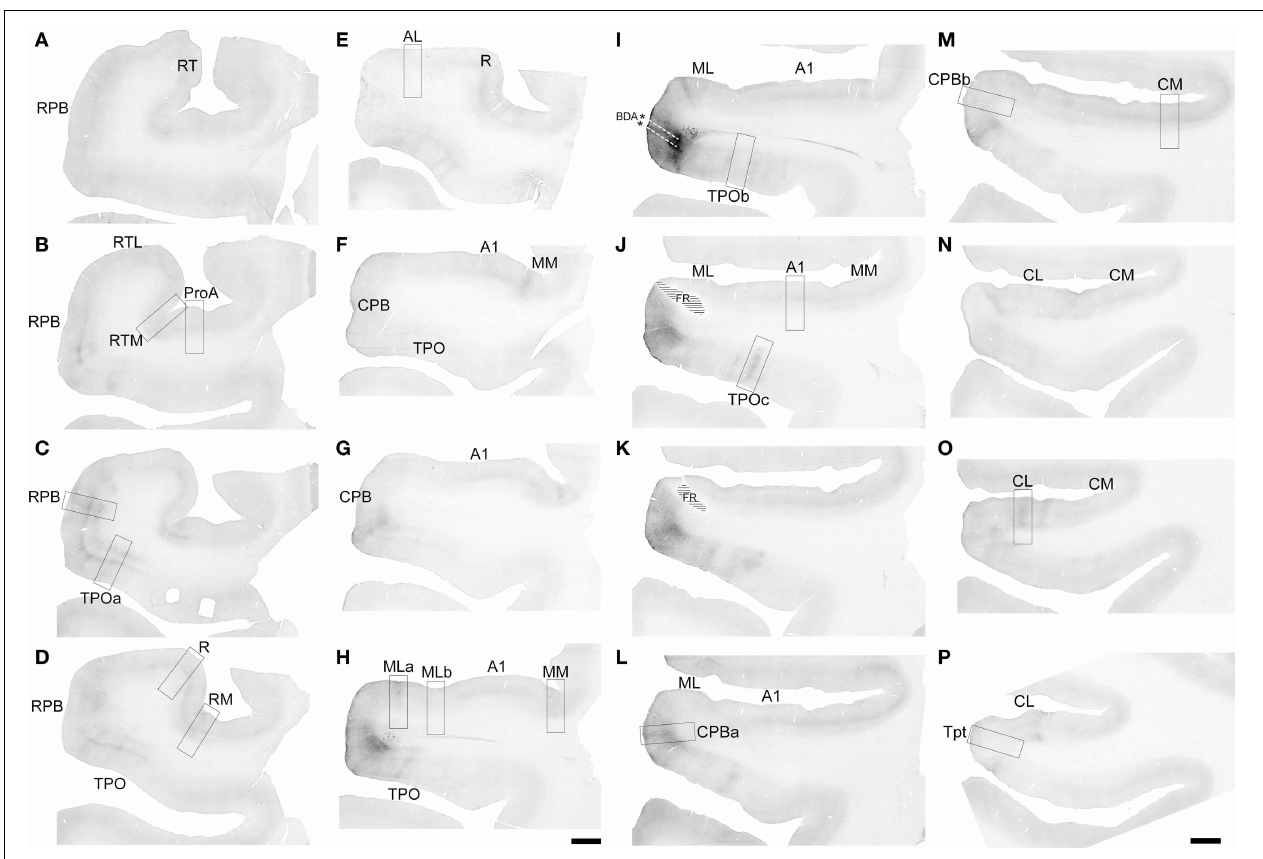
FIGURE 6 | BDA labeling by the injection of CPB in Case 2. Low magnification images of sections oriented from rostral (A) to caudal (P) along the STG. Black signal visible in each panel shows anterograde and retrograde